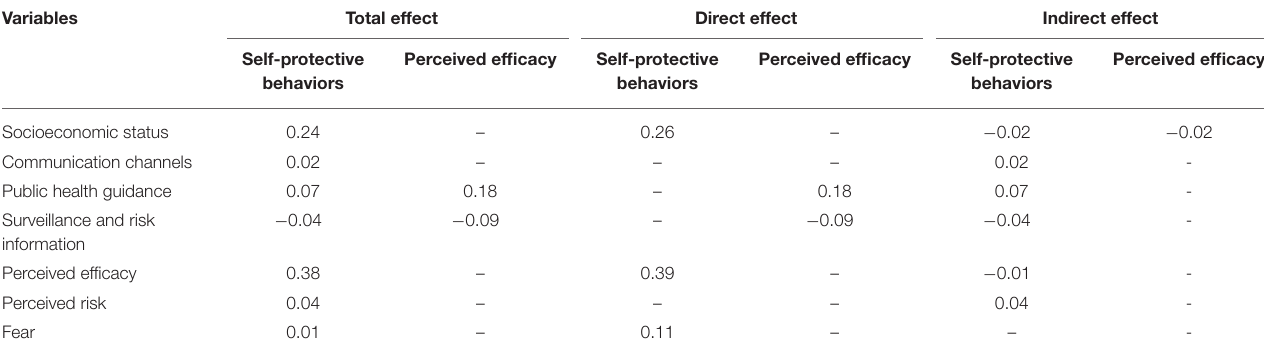
TABLE 2 | Standardized direct, indirect, and total effects of dominants on self-protective behaviors and perceived efficacy in response to COVID-19 among women in rural western China ( N = 1,524).